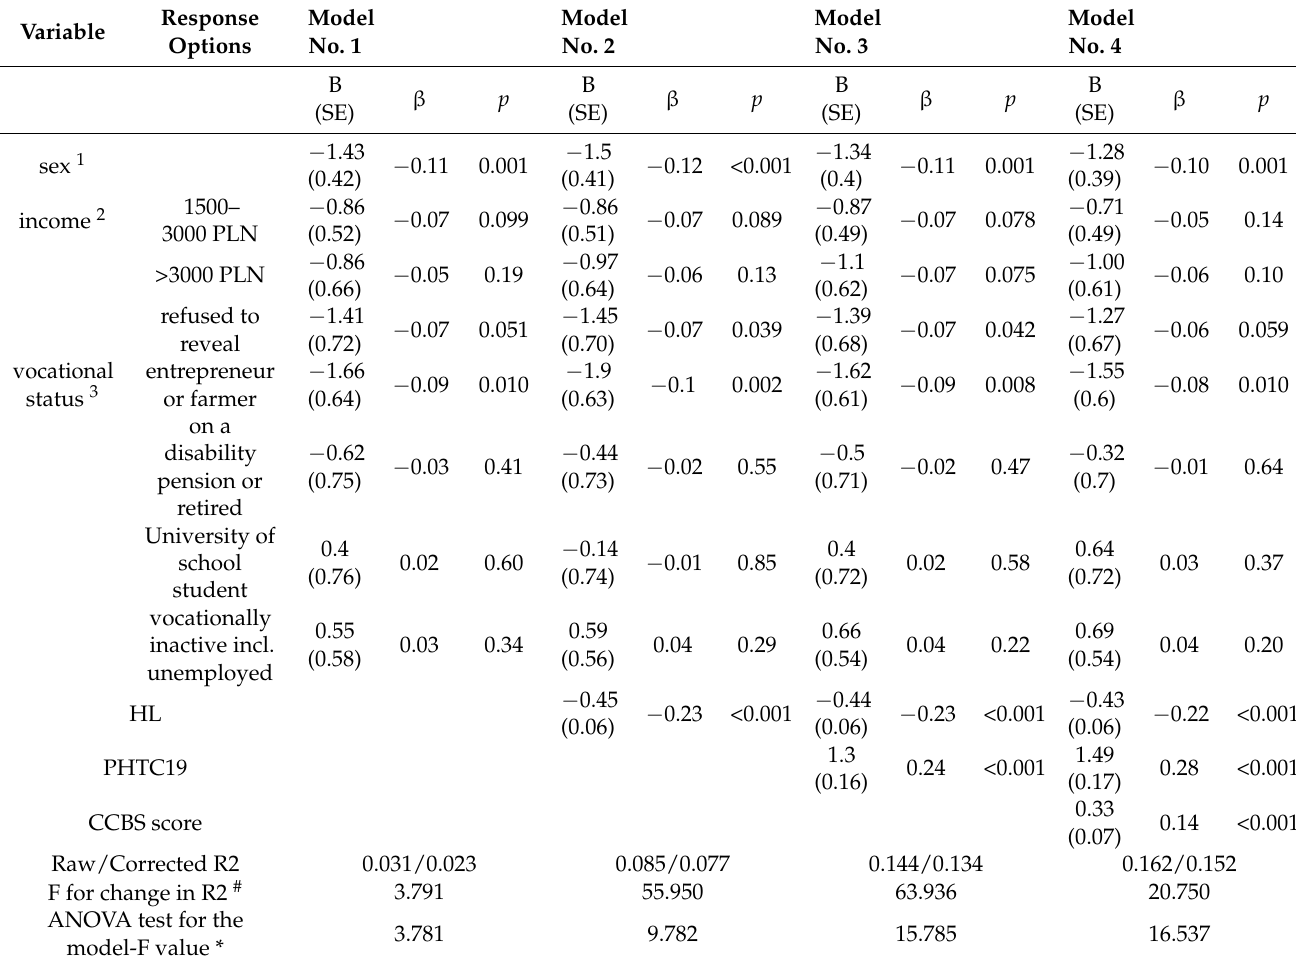
Table 4. Hierarchical linear regression modelling of